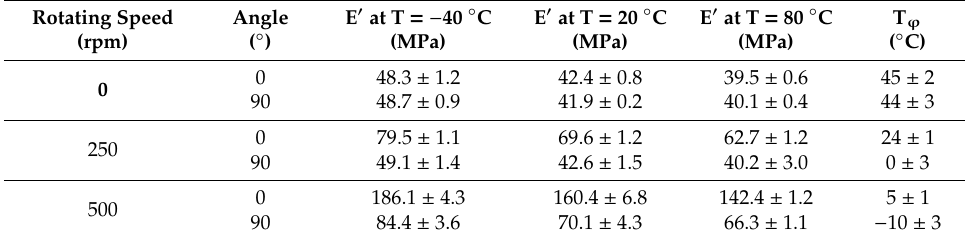
Table 3. Summary of the dynamic-mechanical and dynamic-mechanical-thermal properties of the prepared membranes. E’ values are taken at a frequency of 1 Hz, and T ϕ represents the secondary transition temperature.